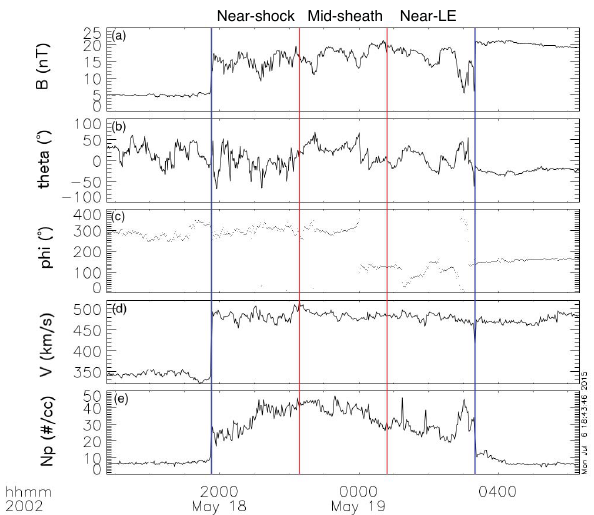
Figure 2. A sheath region on 18 May 2002 observed by Wind. The blue lines indicate the CME shock and the ejecta leading edge (LE), respectively, while the red lines separate the sheath into 33%– 33%–33% sub-regions: Near-Shock, Mid-Sheath and Near-LE do- mains. The shown parameters are from top to bottom: (a) magnetic field magnitude, (b) θ and (c) φ components in GSE angular coor- dinates, (d) solar wind speed and (e) proton density.